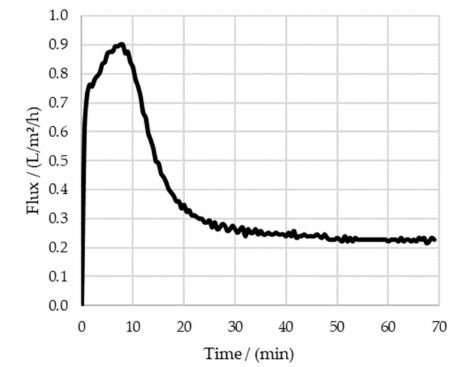
Figure 13. Exemplary flux development over time of a diafiltration